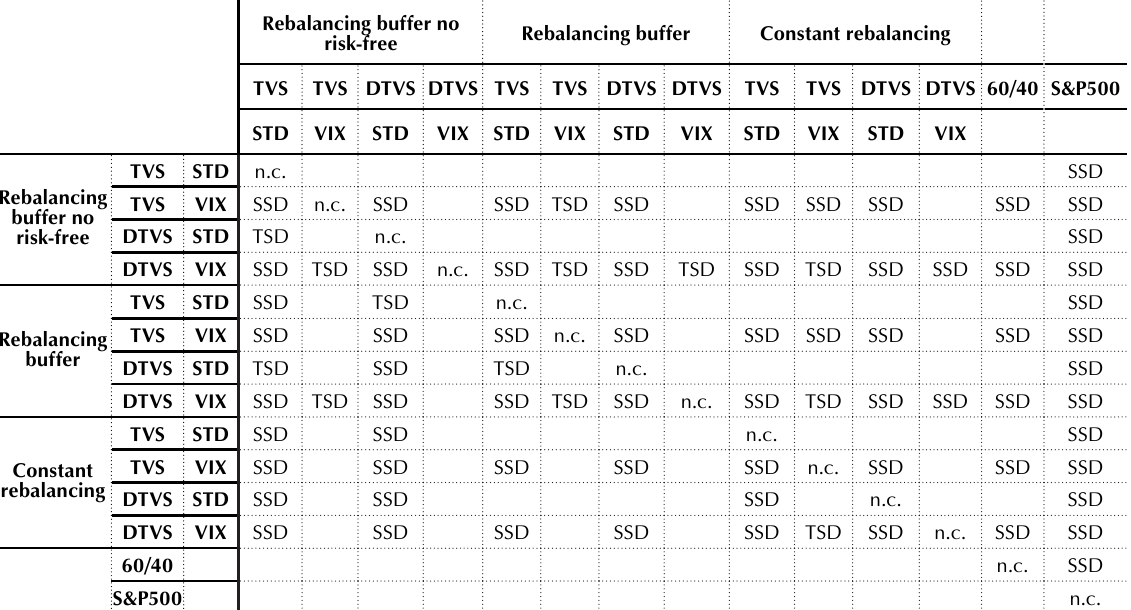
Table 4. Dominance relations between the strategies and the S&P 500